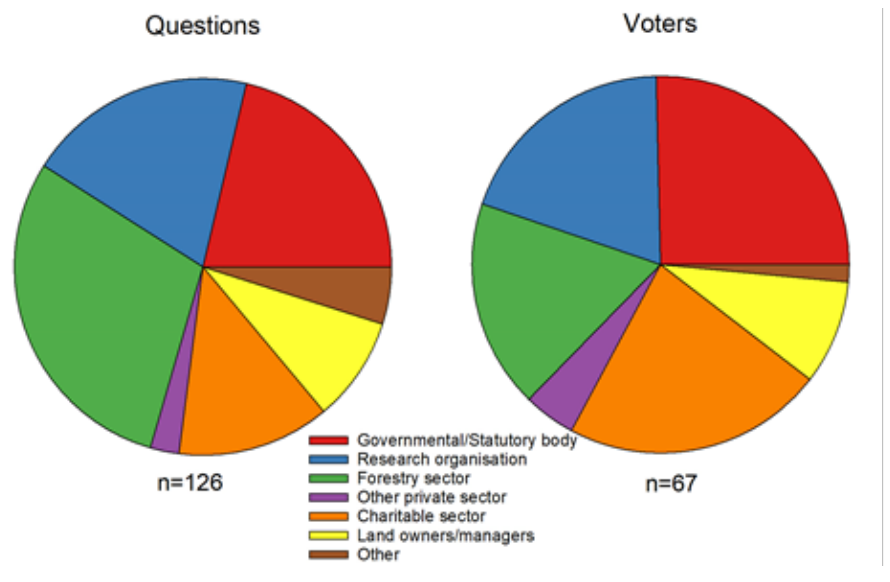
Figure 1. Representation of different sectors (see key) amongst initial question contributors (left) and voters in the second stage survey